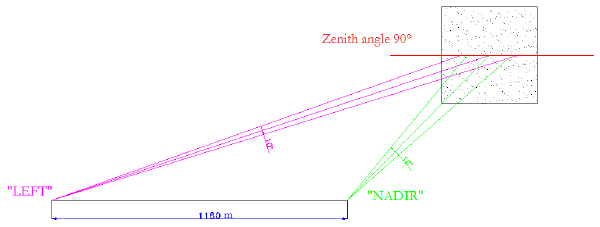
Figure 3 - Relative positions of the sample compared to the system LST